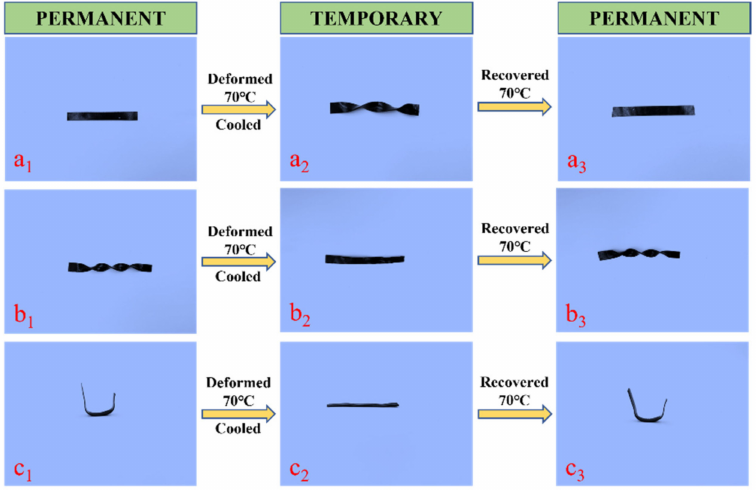
Figure 12. Shape memory behavior of ( a 1 – a 3 ) strip sample. ( b 1 – b 3 ) spiral sample ( c 1 – c 3 ) u-type